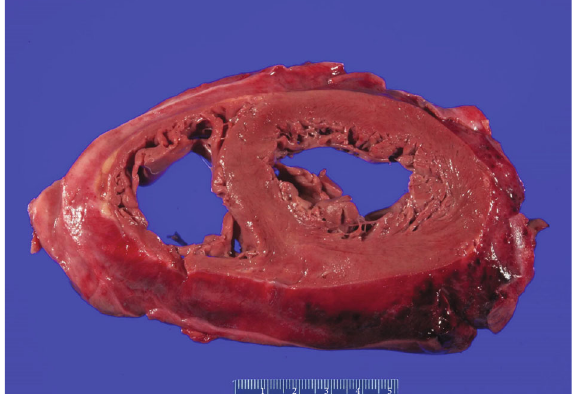
Figure 1: A photograph of a cross-section of the heart with thickened and gelatinous-appearing epicardium.